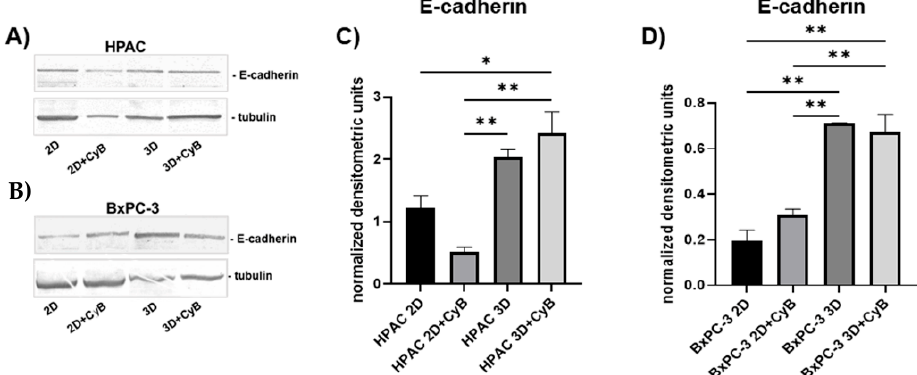
Figure 4. Representative Western blot showing E-cadherin expression in whole cell lysates of HPAC ( A ) and BxPC-3 cells ( B ). Bar graphs showing E-cadherin protein levels after densitometric analysis of immunoreactive bands in HPAC ( C ) and BxPC-3 cells ( D ). Data are expressed as mean ± SD. * p < 0.05, ** p < 0.01.